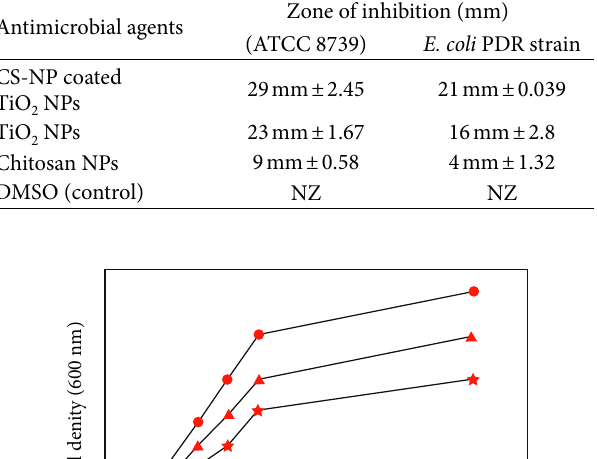
Table 2: Zone of inhibition and SD values of formulated Nano antimicrobial agents.